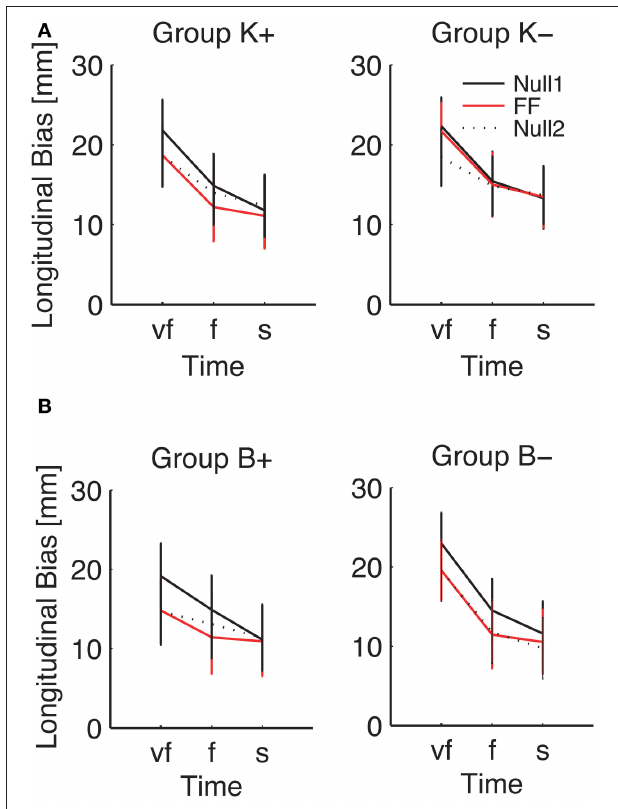
FIGURE 7 | Effect of the force field on the SAT curve (longitudinal bias, high-inertia direction), for (A) position-dependent and (B) velocity-dependent field. Curves are averaged over subjects for each phase and field type. The different colors denote different phases: Null1 (black), Field (red), Null2 (dotted black). The differences between Null1 and FF indicate perturbation effects. The differences between Null1 and Null2 indicate carryover effects. Vertical bars denote the SE.